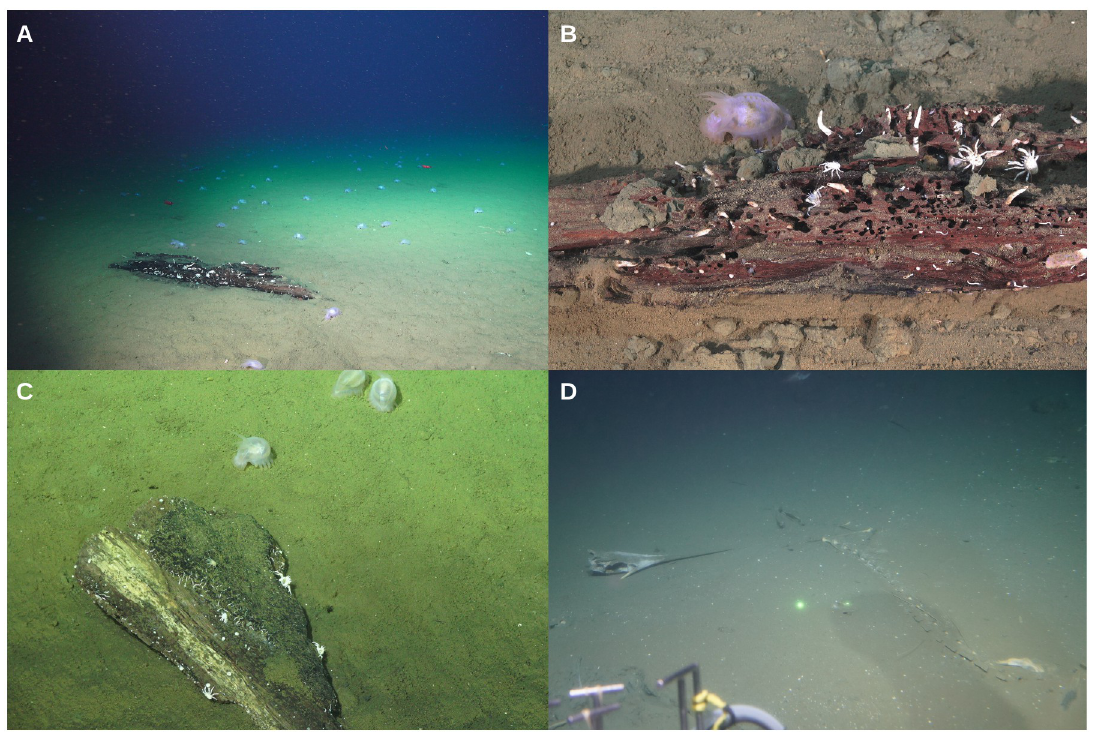
Fig 3. Natural organic falls observed in the vicinities of methane seeps off the Costa Rican margin. (A) Wood found at Jaco Scar (~2,000 m) and a (B) closeup. (C) Wood found at Mound 12 (~1,000 m). (D) Swordfish skeleton found at Quepos Slide (~400 m). Although we only collected samples from the woods, the skeleton observation illustrated here further highlights the common occurrence of natural organic falls in the vicinities of methane seep sites off the Costa Rican